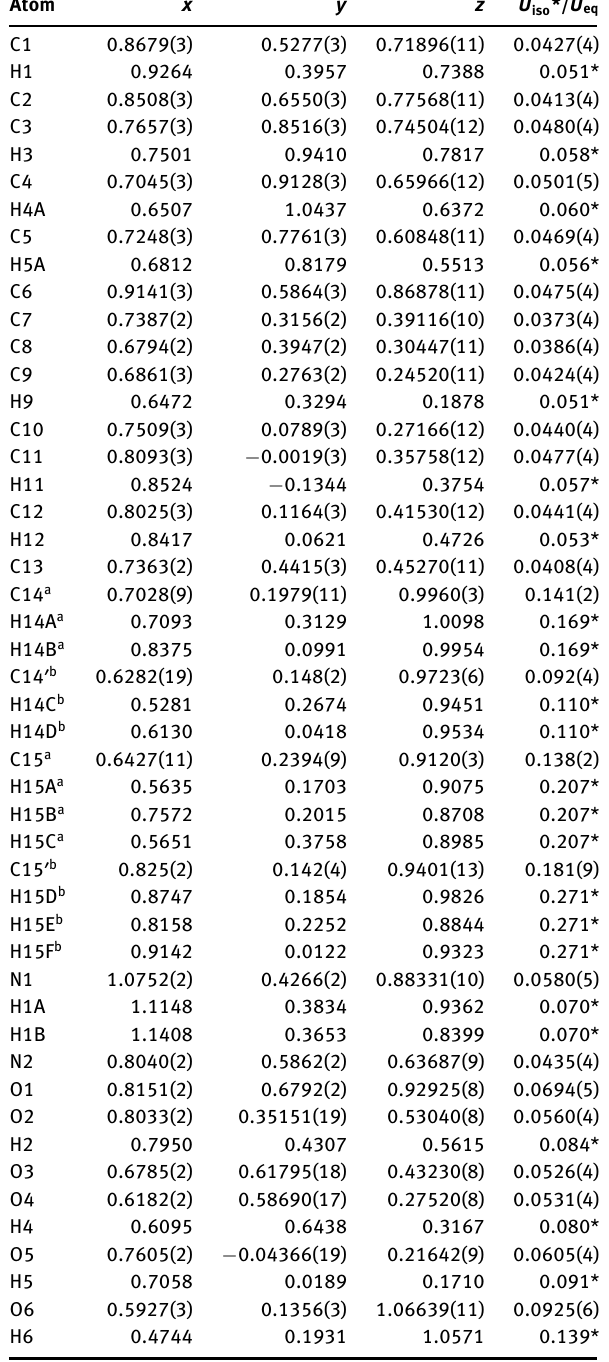
Table 2: Fractional atomic coordinates and isotropic or equivalent isotropic displacement parameters (Å 2